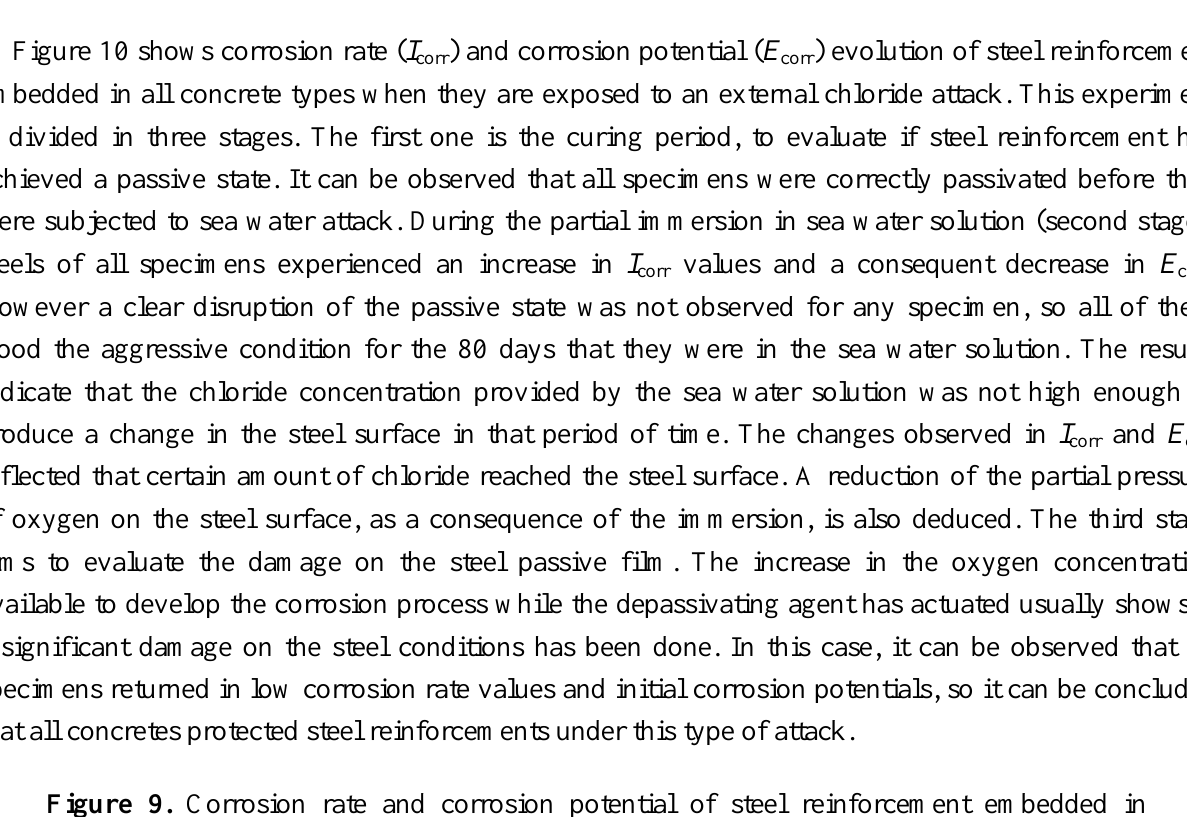
Figure 9. Corrosion rate and corrosion potential of steel reinforcement embedded in RA-AB specimens and different chloride